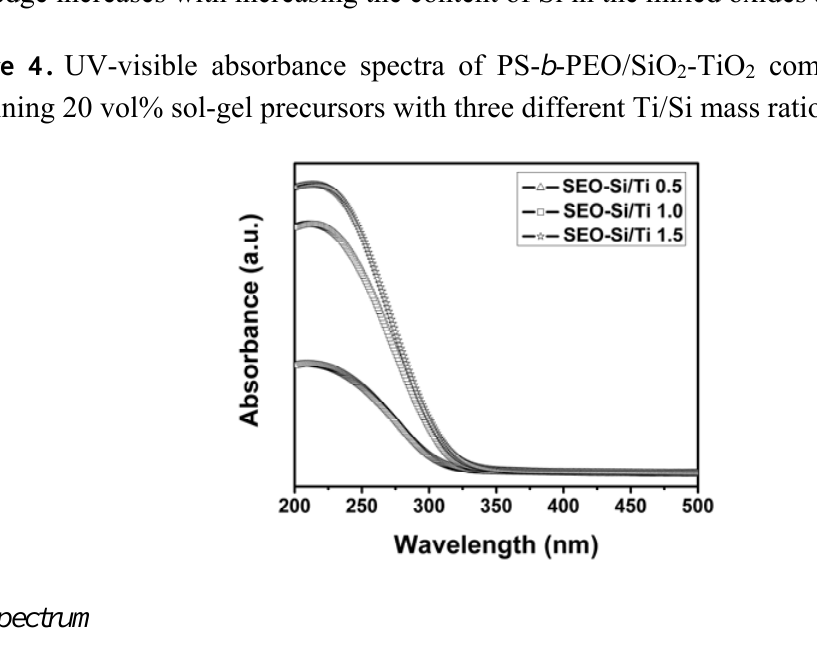
Figure 4. UV-visible absorbance spectra of PS- b -PEO/SiO